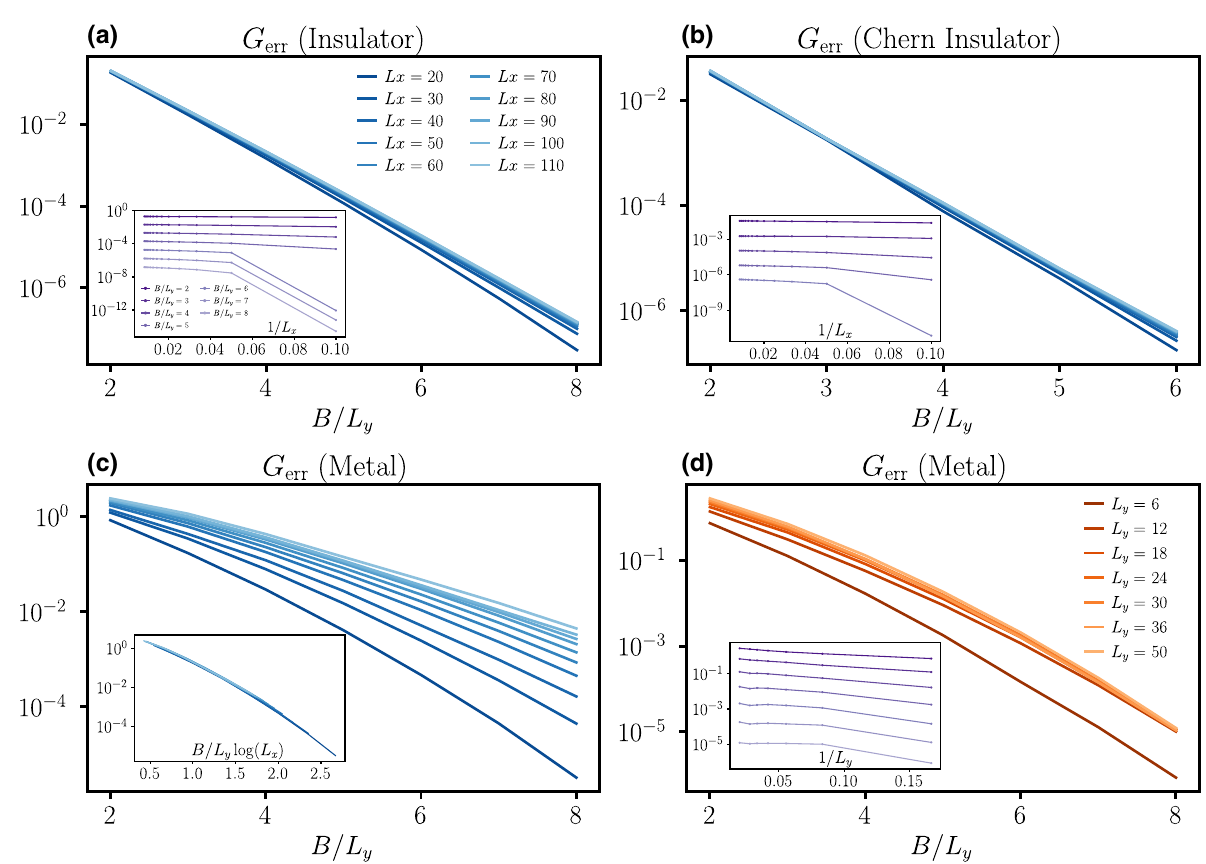
FIG. 7. GMPS compression resource scaling: (a)–(d) show the mean error G err of Green’s functions versus the GMPS compression block size for various systems and system sizes. G err is defined by G err = compressed Green’s function and V is the system size. In each plot we stop at the block size when the eigenvalues cannot be improved by increasing block size as it already reaches the limit of machine precision 10 − 15 . (a)–(c) show the error versus the block sizes for different L x while L y is fixed (to 1,6,6); (d) shows the compression error versus the block sizes for different L y with L x = 50. The insets of (a),(b),(d) show the G err versus 1 / L x or 1 / L y . The inset of (c) shows the G err versus the block size rescaled by log ( L x )